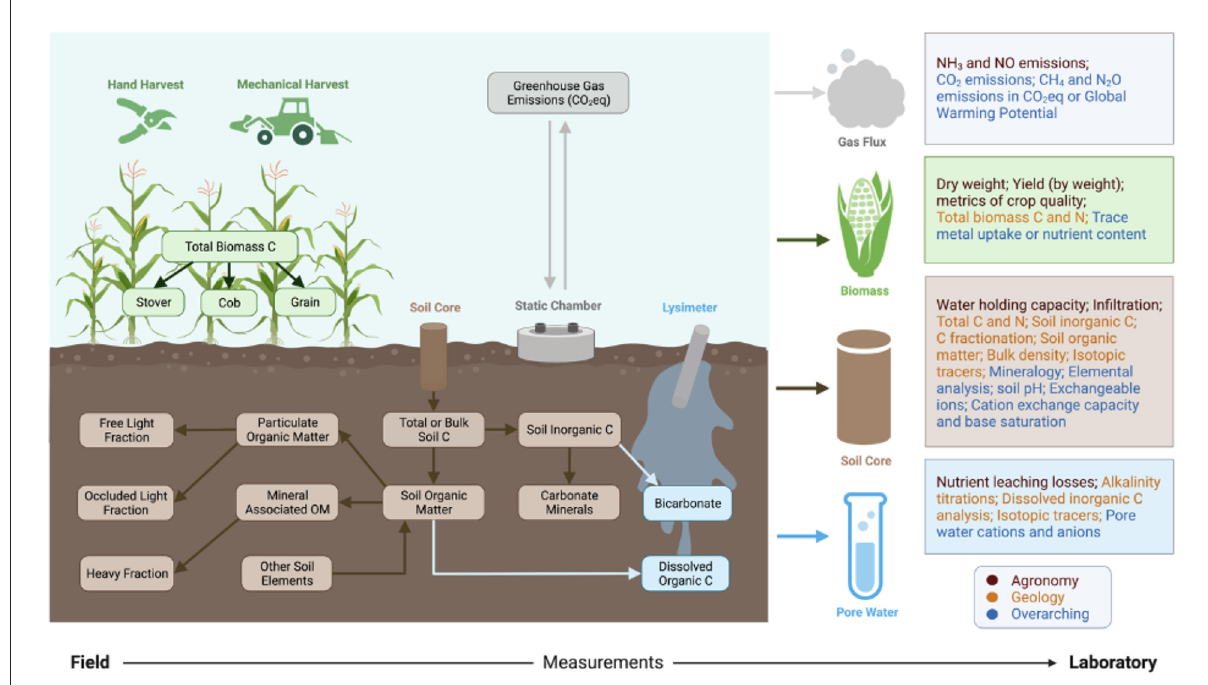
FIGURE2 Flow chart for field measurements, sample collection, and laboratory analyses from enhanced weathering studies in working land environments.